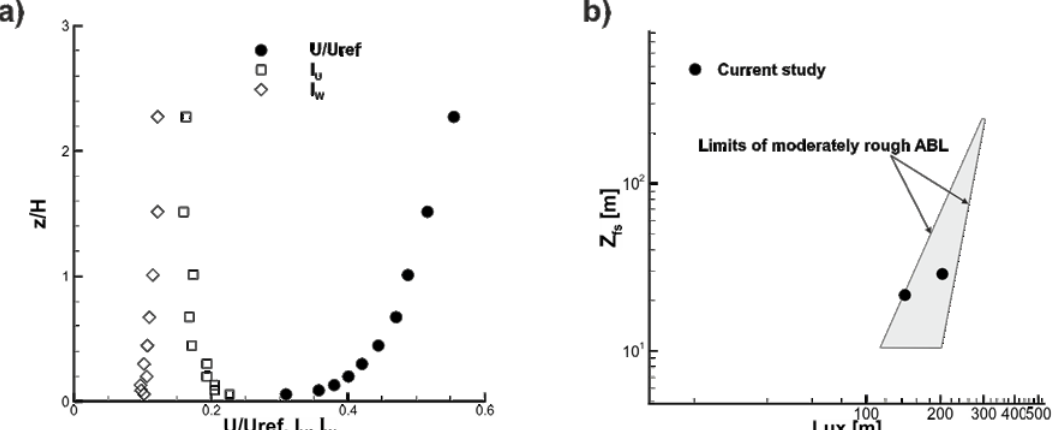
Fig. 2. a) Mean dimensionless vertical profiles of longitudinal velocity ( filled circles ) and longitudinal ( empty squares ) and vertical ( empty diamonds ) turbulence intensity of the simulated ABL; b) Comparison of the modelled ( filled circles ) integral length scales of turbulence ( L ux ) in WT with those ( greyed area) recommended for moderately rough ABLs by VDI guidelines at full scale. smallest dimension of the room) should be at least